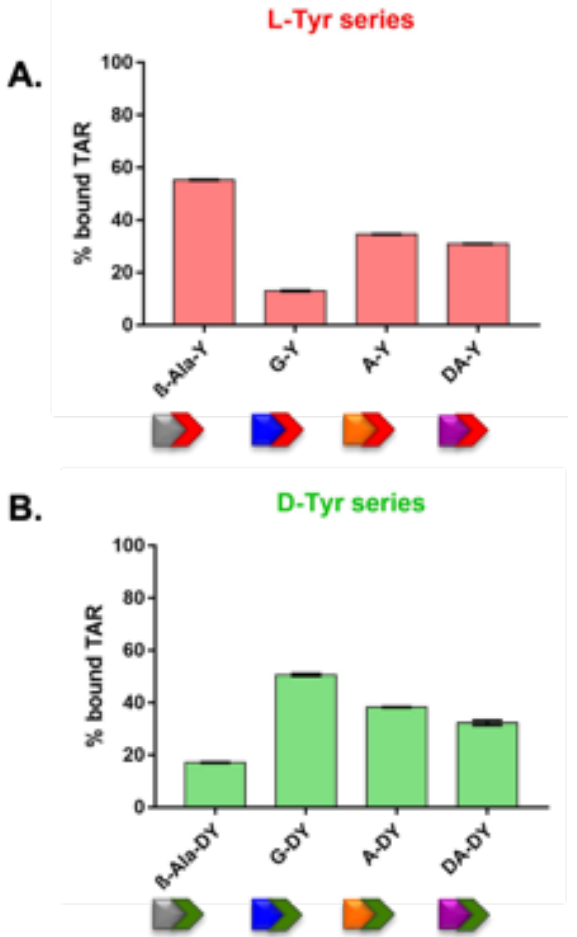
Figure 3. Histograms displaying the percentages of bound substrate observed in the ESI-MS spectra obtained by mixing TAR with the compounds of the L -Tyr ( A ) and the D -Tyr ( B ) series. The indicated percentages of bound substrate provide a measure of the relative affinities of L - and D -analogues for the nucleic acid substrate.